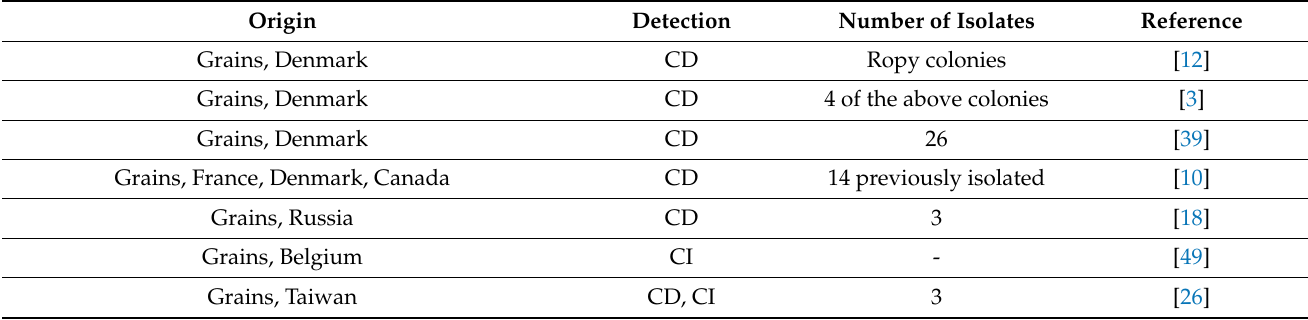
Table 2. Lactobacillus kefiranofaciens detection in and isolation from kefir grains and beverages in chronological